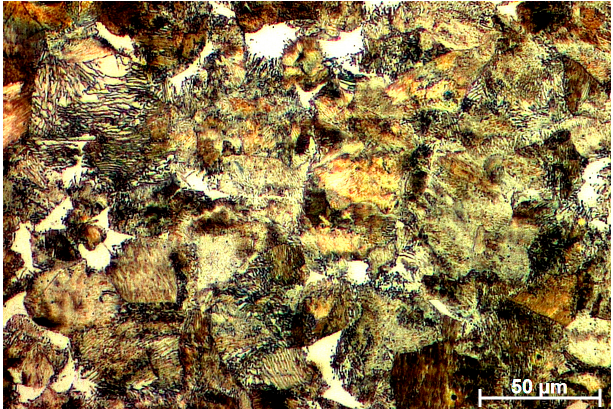
Figure 3. Flow curve determined at room temperature and strain rate of 0.01 s − 1 for the material 42SiCr in a normalized state.